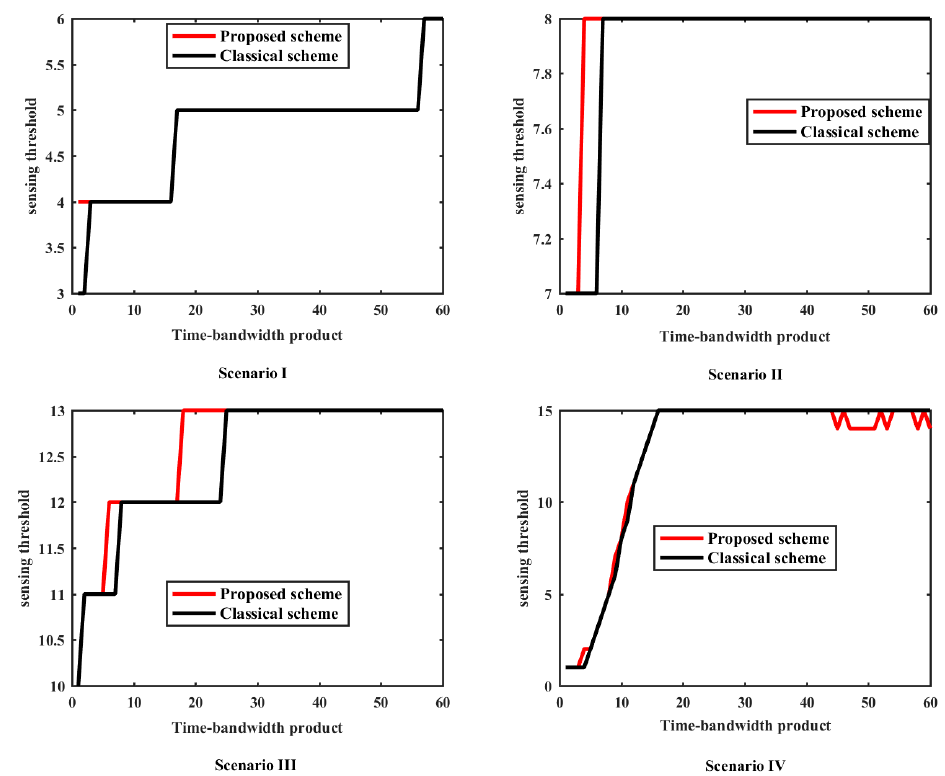
Figure 2. The sensing threshold comparisons under various scenarios with the different time-bandwidth products. Scenario I 、 Scenario II 、 Scenario III and Scenario IV respectively corresponds with the scenarios mentioned above. The total error probability is shown in Figure 3 under four scenarios. The red line denotes the proposed scheme, where both the sensing threshold and the minimum total error probability are with the proposed scheme. The black line denotes the minimum total error probability with the classical scheme. The blue line denotes the real minimum total error probability with the proposed sensing threshold. The main difference between the red line and the green line is that the minimum total error probability of the red line is evaluated by the proposed scheme in this paper and the minimum total error probability of the green line is calculated by the evaluated sensing threshold in this paper.